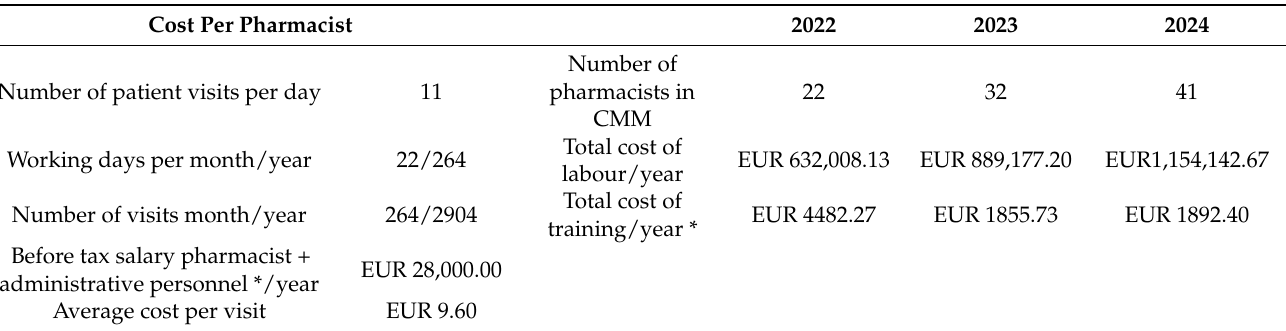
Table 3. Eligible population and the number of patients in